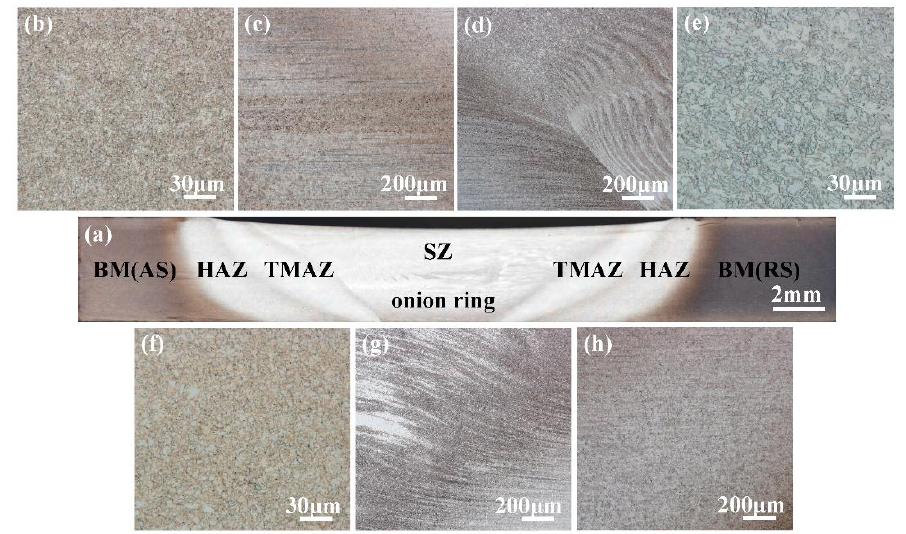
Figure 2. Schematic for distributed regions of FSW specimen and its relative optical micrographs of different distributed regions: ( a ) transverse section of joint; ( b ) base metal (BM); ( c ) heat-affected zone advancing side (HAZ-AS); ( d ) thermo-mechanically-affected zone/stir zone advancing side (TMAZ)/(SZ-AS); ( e ) stir zone top (SZ)-top; ( f ) SZ-bottom; ( g ) TMAZ/SZ-retreating side (RS); ( h ) HAZ-RS.